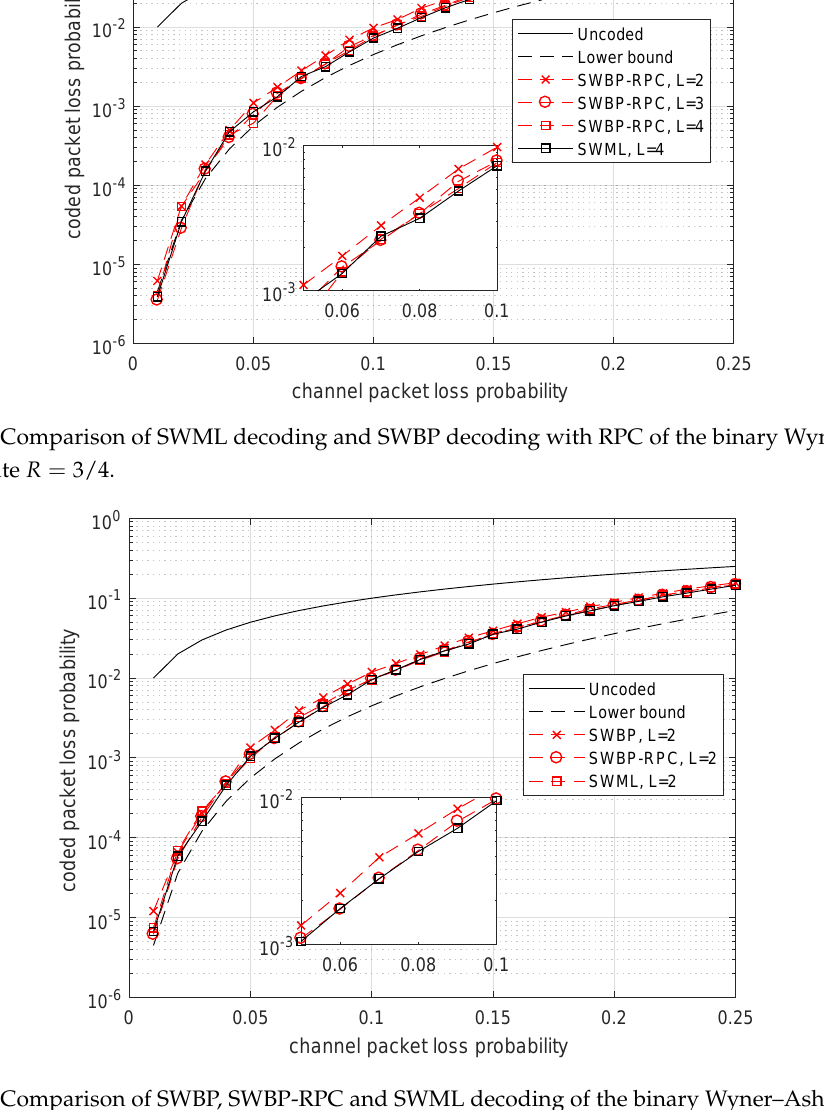
Figure 4. Comparison of SWBP, SWBP-RPC and SWML decoding of the binary Wyner–Ash code of rate R =